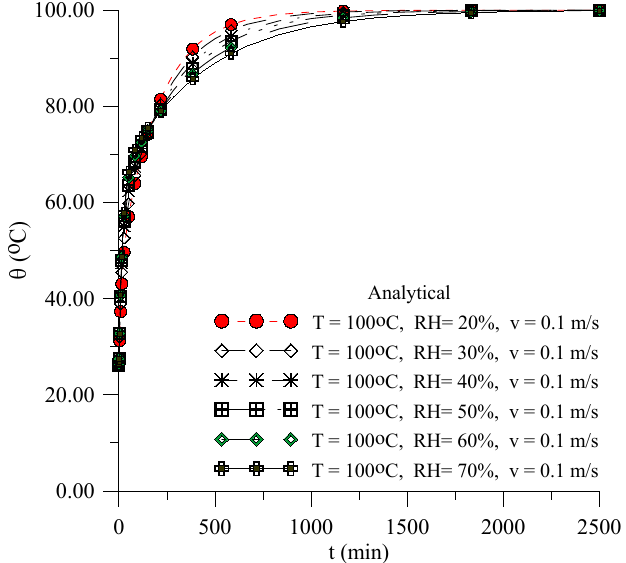
Figure 8. Temperature at the vertex of the industrial ceramic brick as a function of time for different relative humidity of the drying air.